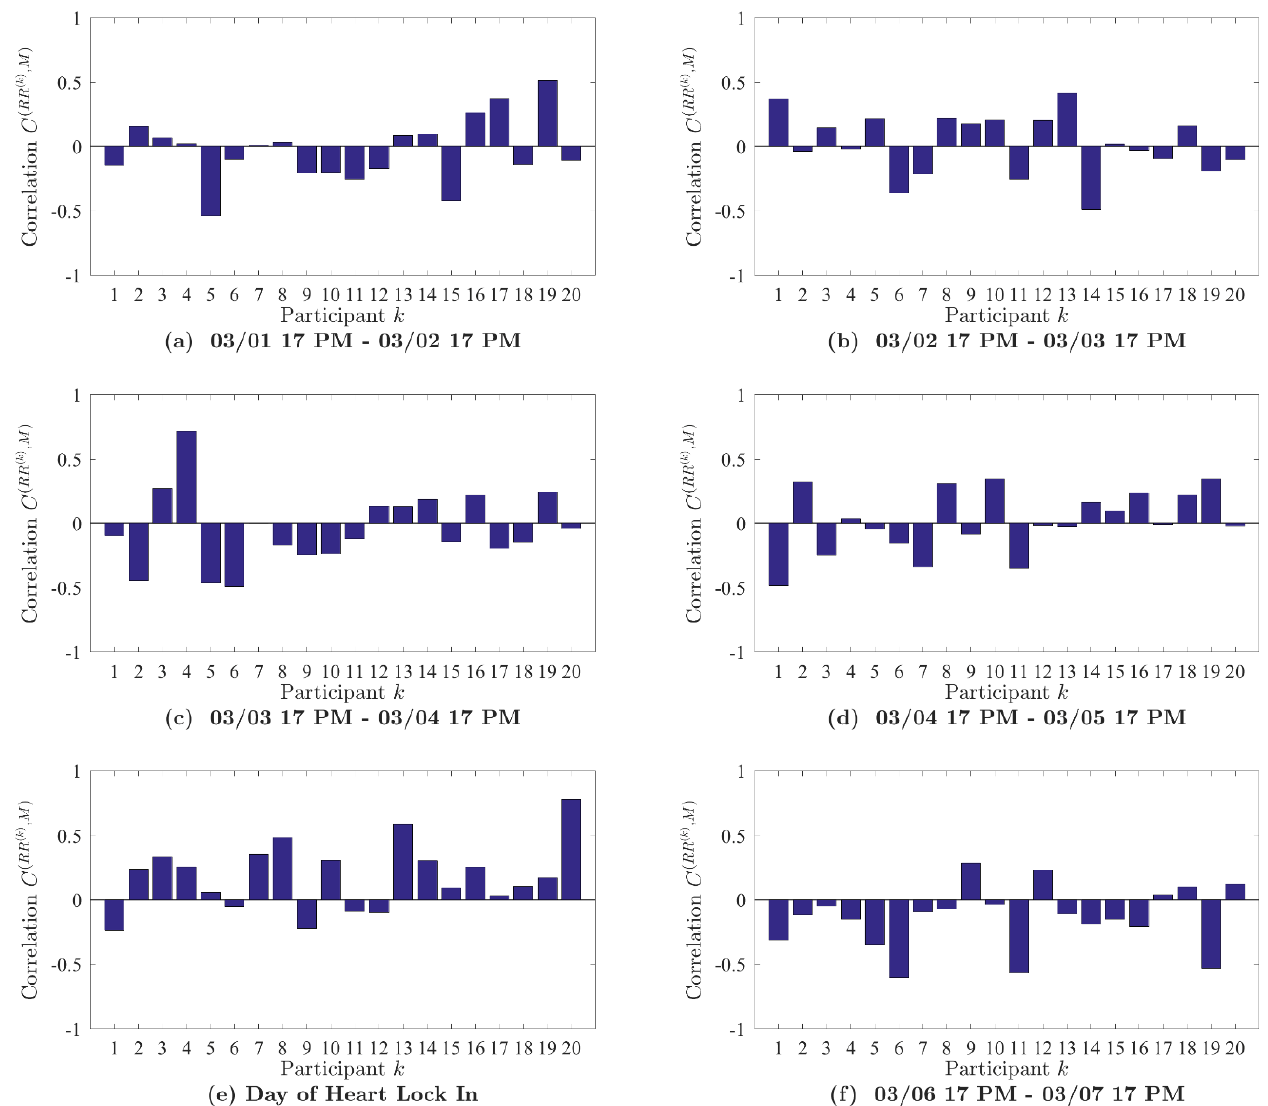
Figure A4. The results of the analysis of the LMF-HRV-synchronization for Saudi Arabia. Each part of the figure displays participants’ LMF-HRV-synchronization for the indicated day. Plot (e) corresponds to the day of the Heart Lock-In. Note that most of the participants’ HRV signals shifted to being positively correlated (synchronized) with LMF on the day of the Heart